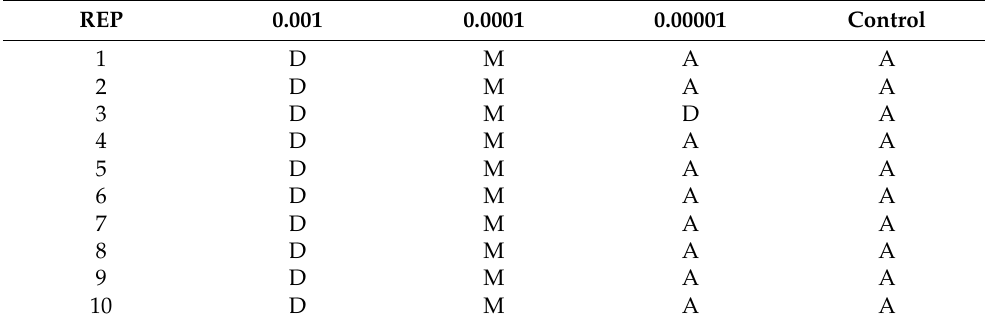
Table 3. Imidacloprid w/C. circumpicta larvae. Dilutions mixed at 1 mg/1 mL stock solution. Ten repetitions with control (acetone) at determined concentrations. 48 h exposure. D = Dead; A = Active; M = movement with stimulation. LD 50 = 0.001 mg/mL.